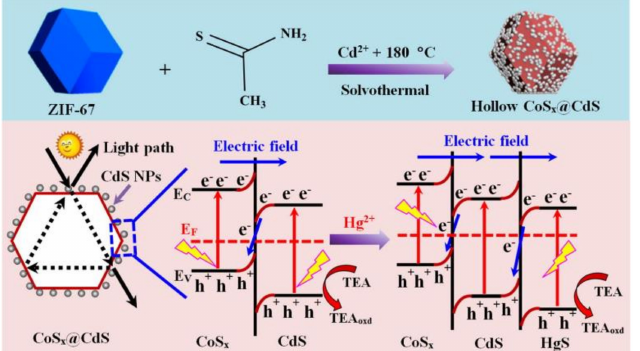
Figure 8. Synthetic process of hollow CoS x polyhedrons and CoS x @CdS composites and the mechanism of photocurrent responses of CoS x @CdS composites, showing the band structures of CoS x @CdS/HgS composites and charge separation under the visible-light illumination (Reproduced with the permission from Ref